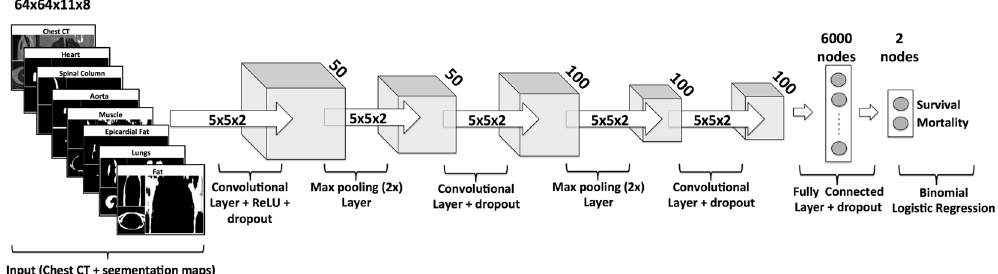
Figure 5. Schematic of the deep learning architecture for the mortality classification